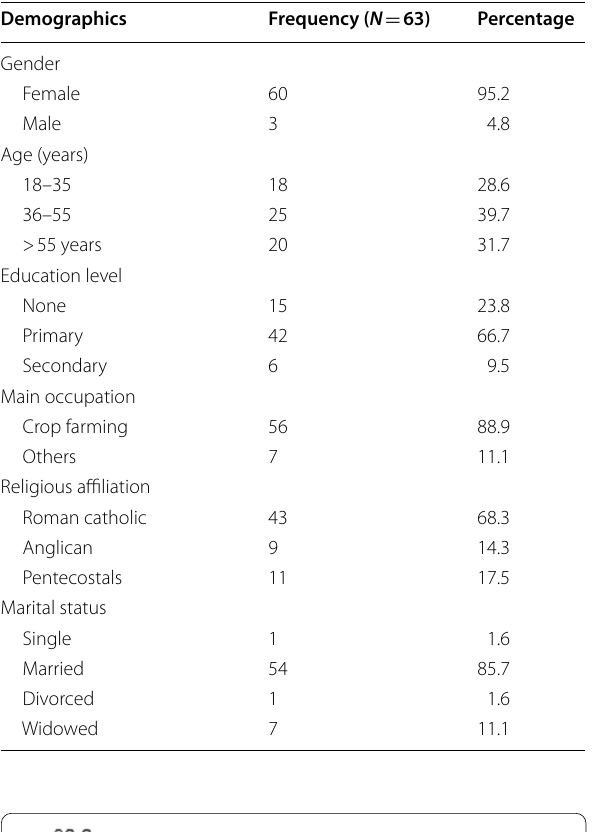
Table 1 Socio-demographic characteristics of herbalists